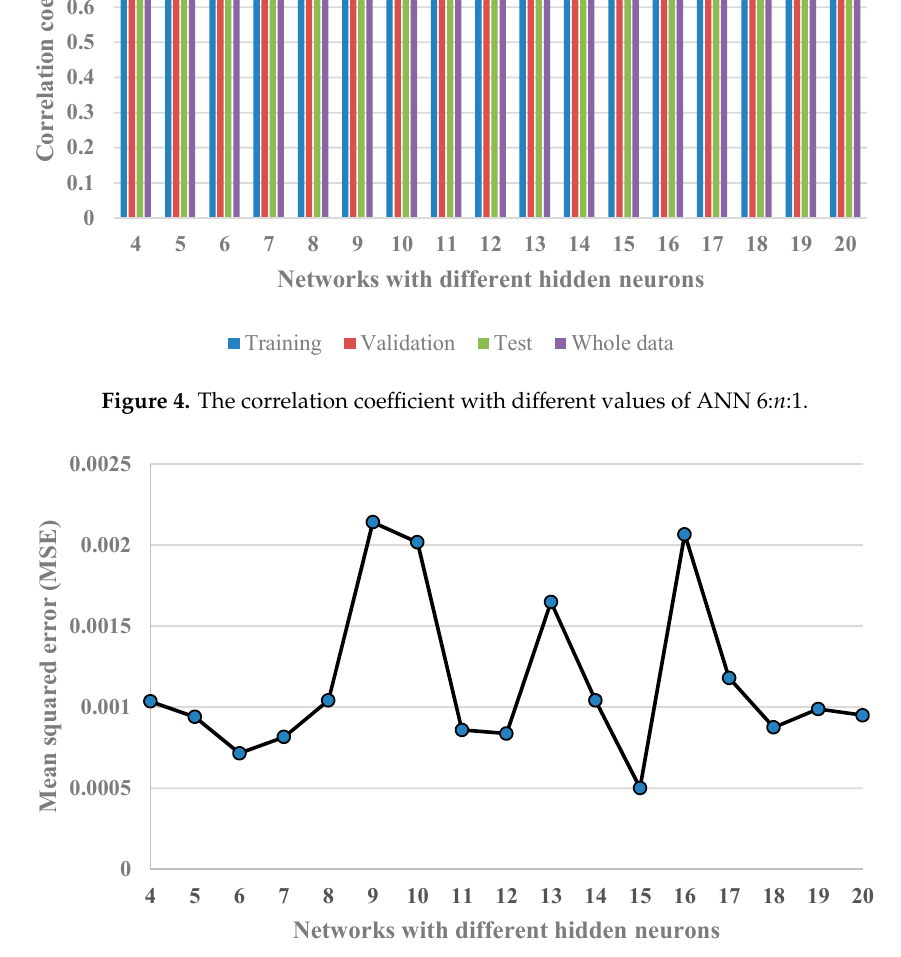
Figure 5. Mean squared error (MSE) versus some hidden-layer neurons.